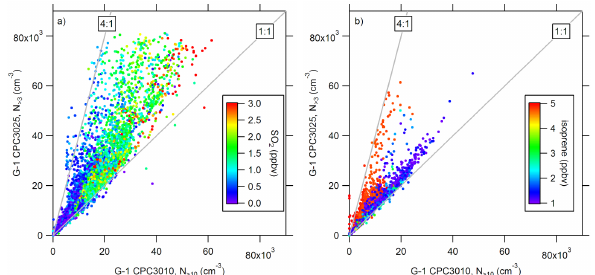
Fig. 10. Scatter plots of CPC-3025 vs. CPC-3010 number concen- trations observed on the G-1: (a) the points are colored by the corre- sponding SO 2 mixing ratios; (b) the points are colored by the corre- sponding isoprene mixing ratios (points with isoprene mixing ratios < 1ppbv were removed from the plot for clarity). Grey lines show slopes of 4:1 and 1:1.